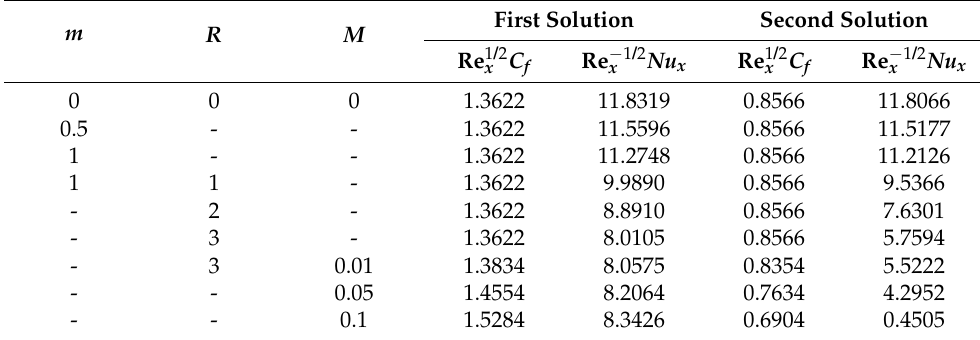
Table 4. Values of Re 1/2 x C f and Re − 1/2 x Nu x when ϕ hnf = 2%, S = 2 and λ = − 1 (shrinking sheet) for different physical